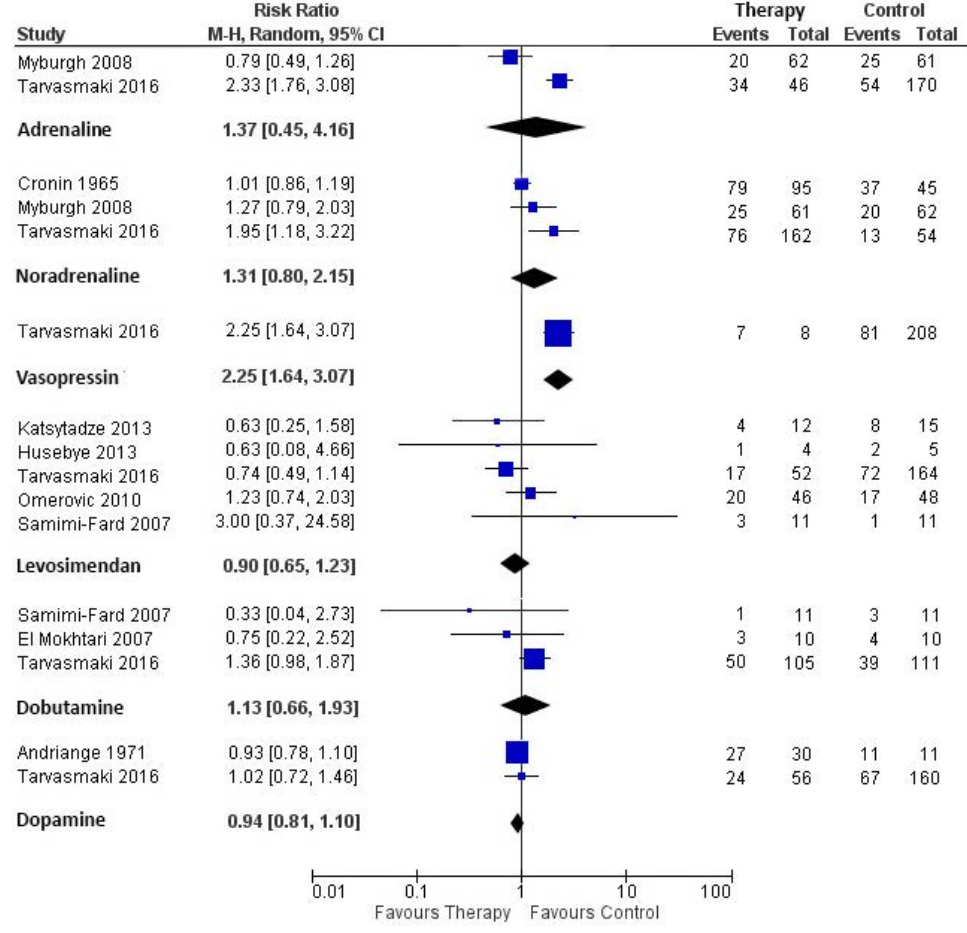
Figure 3. Forest plot demonstrating long-term ( ≥ 90 day) mortality of cardiogenic shock patients with a vasopressor / inotrope versus a constructed control treated with a vasopressor/inotrope versus a constructed control group.